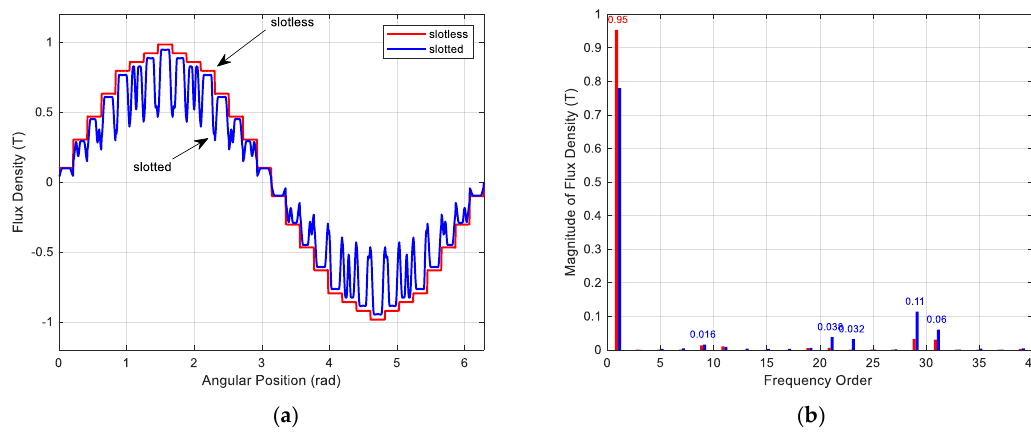
Figure 2. ( a ) Air gap field generated by 5-phase winding; field distribution ( left ), ( b ) frequency spectrum ( right ).